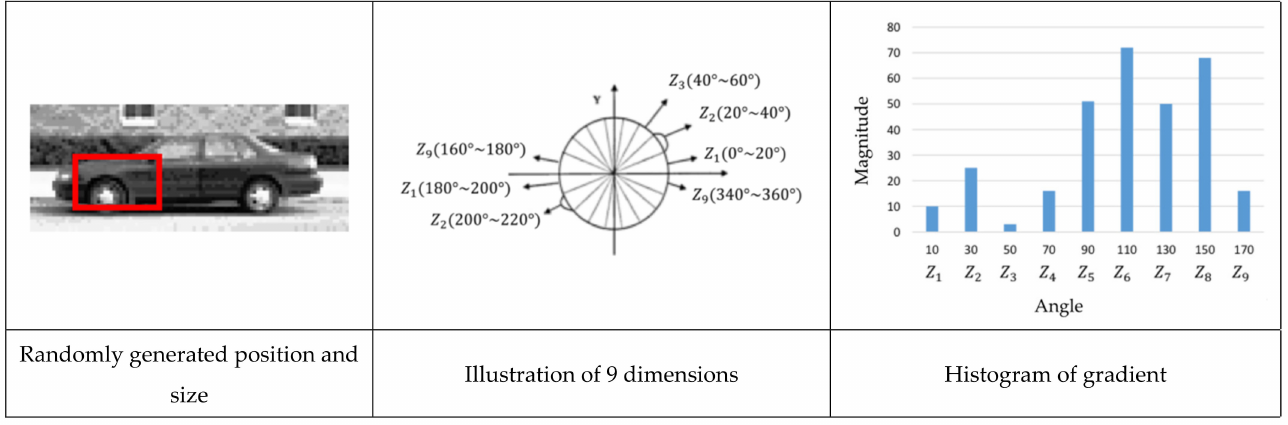
Figure 7. Feature extraction process of